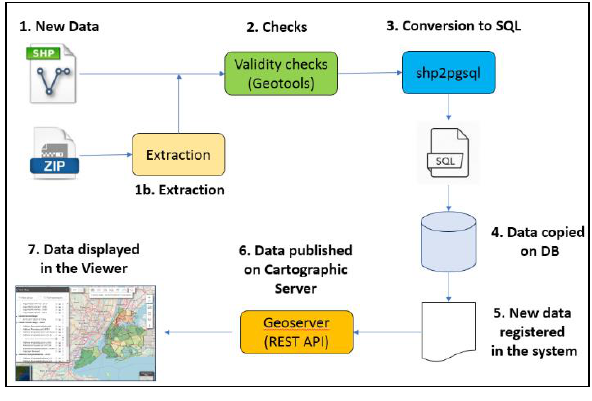
Figure 19. Data Loading